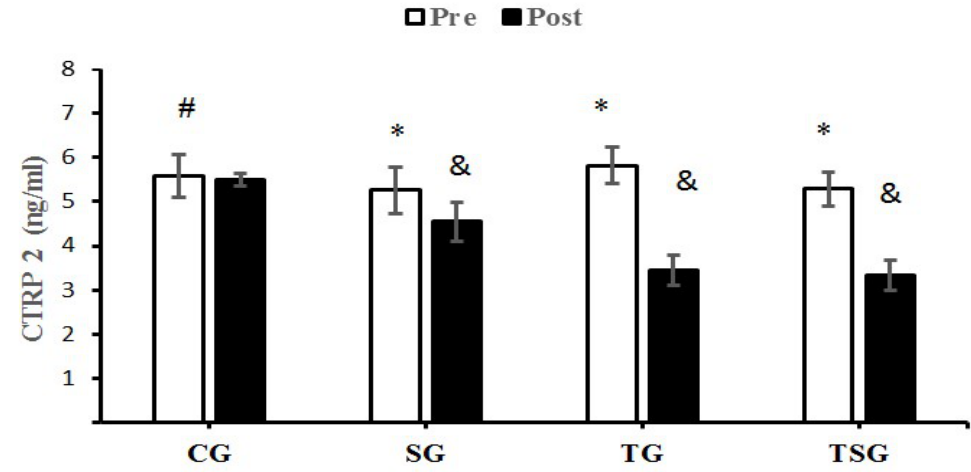
Figure 2. Pre- and post-training values (mean ± SD) for CTRP2 in the control (CG), supplement (SG), training (TG), training + supplement (TSG) groups. & Significantly different from pretest values ( p < 0.05). * Significantly different from control group ( p < 0.05). # Significant time X group interaction ( p < 0.05).